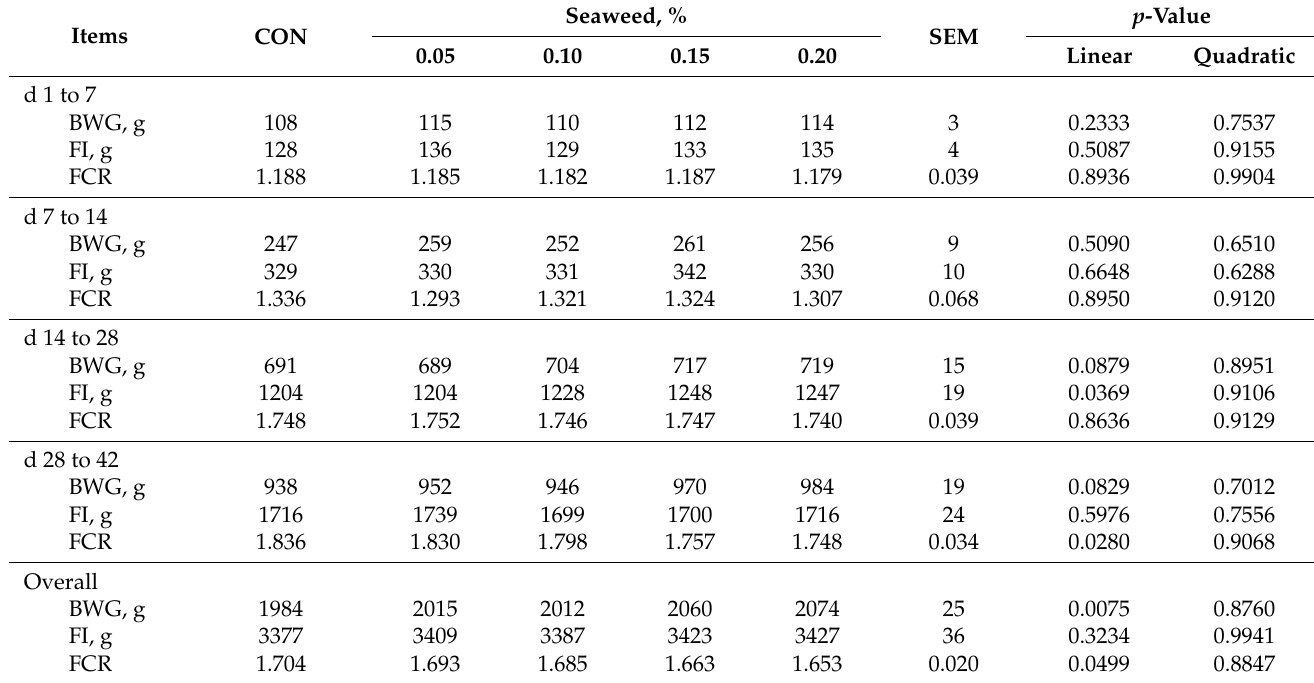
Table 3. The effect of red seaweed supplementation on growth performance in broilers 1 .